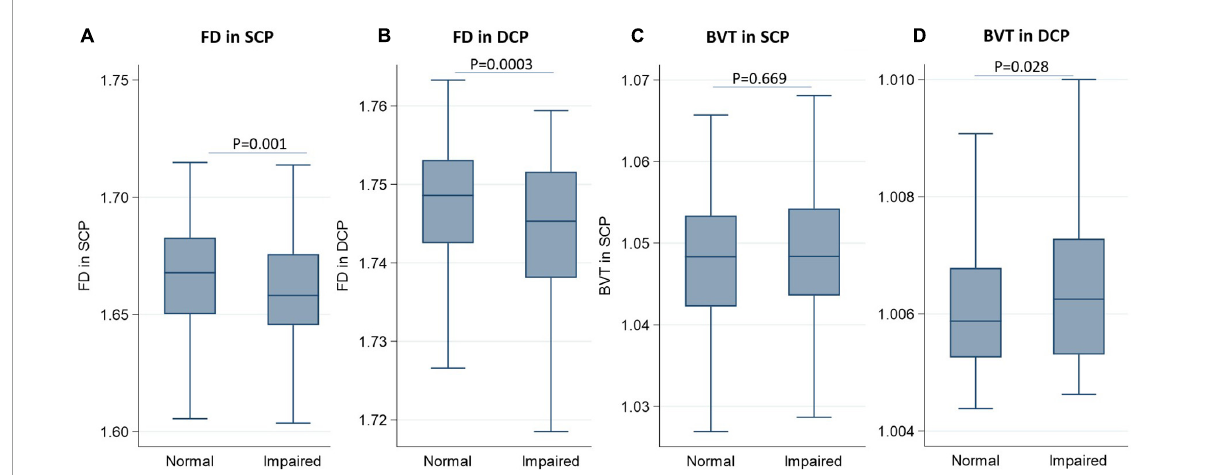
FIGURE1 Boxplots showing the distribution of fractal dimension and blood vessel tortuosity in the superficial capillary plexus and deep capillary plexus stratified by renal function. (A) Fractal dimension in the superficial capillary plexus; (B) fractal dimensionin the deep capillary plexus; (C) blood vessel tortuosity in the superficial capillary plexus; (D) blood vessel tortuosity in the deep capillary